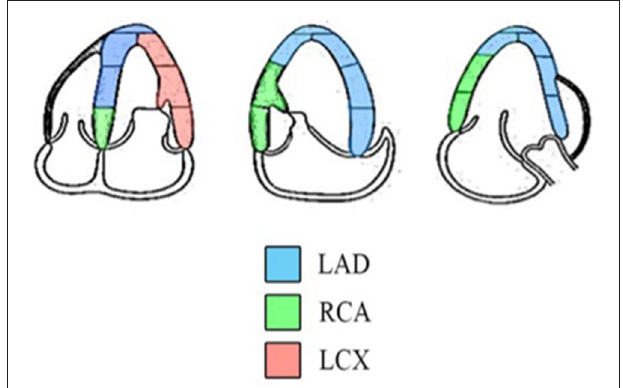
FIGURE 1 | Diagram indicating the distributions of coronary artery perfusion. The myocardium is supplied by the LAD, RCA, and LCX